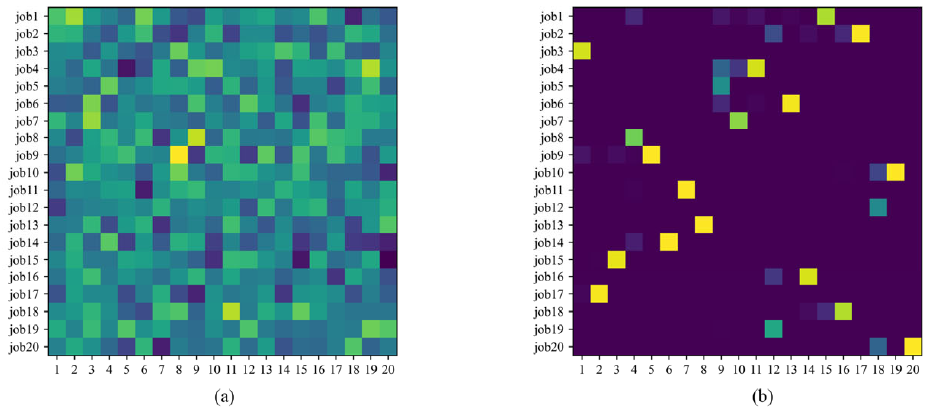
Figure 12. The heat map of the probability distribution of attention. (( a ) denotes the matrix before training, ( b ) is the matrix after training)